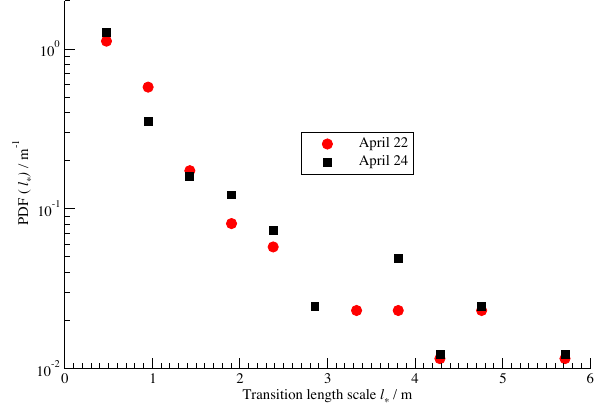
Fig. 13. Probability density function of the transition length scale l ? for 22 and 24